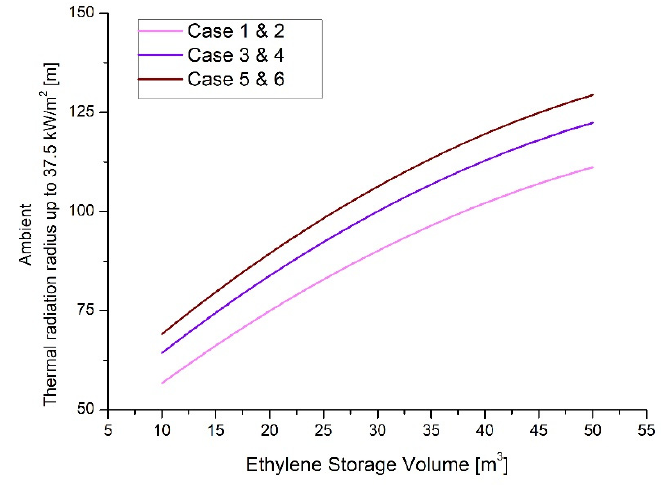
Figure 2. Thermal radiation radius up to 37.5 kW/m 2 according to ethylene storage capacity at ambient temperature (25 °C).